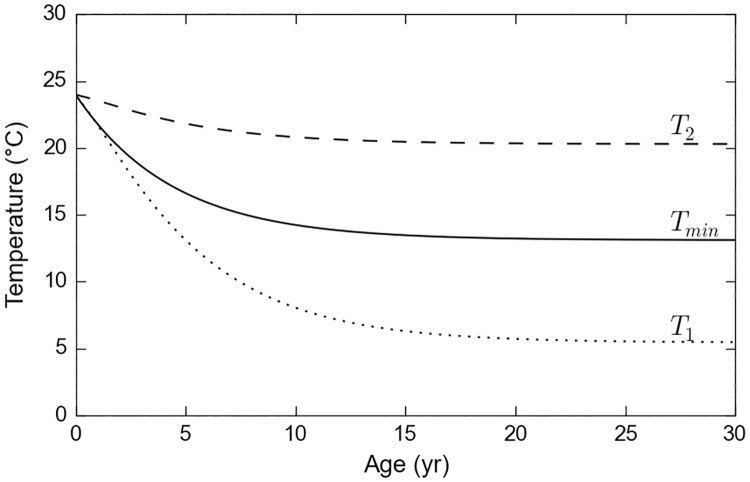
Evolution with age of the lower pivotal water temperatures T1 andT2, and the minimum tolerated temperature (Tmin) defined by GAL.